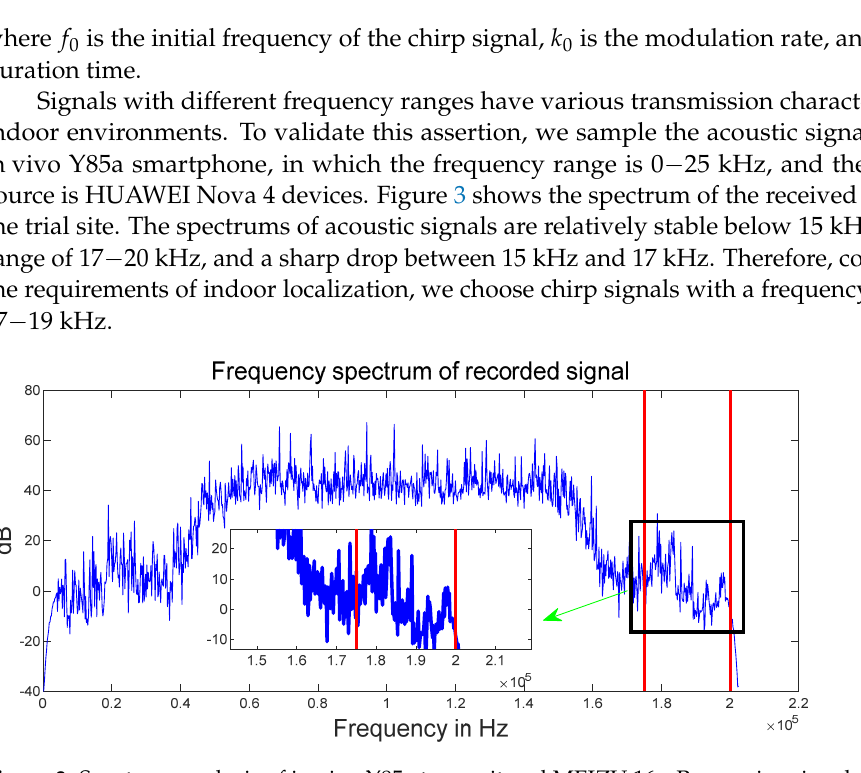
Figure 2. Detailed technical implementation of the proposed fuse localization system.